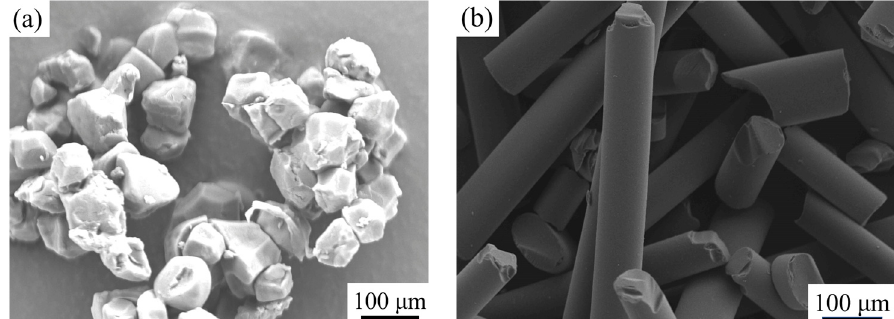
Figure 1. SEM photos of the pore-forming agents ( a ) starch and ( b ) carbon fibers.